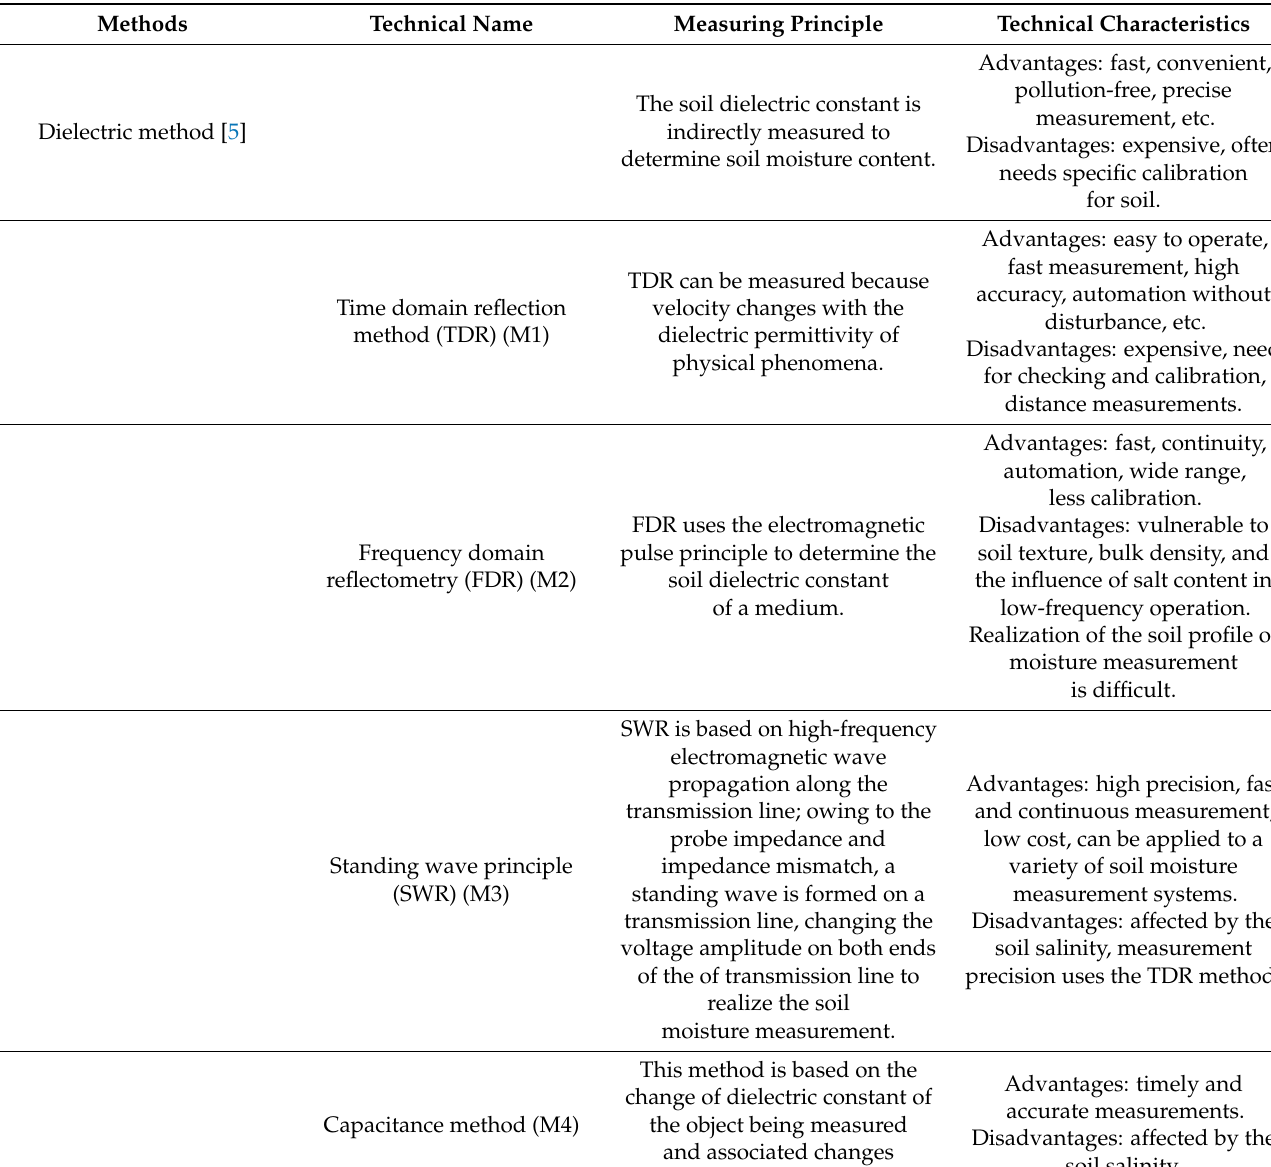
Table 1. Soil moisture sensing technology